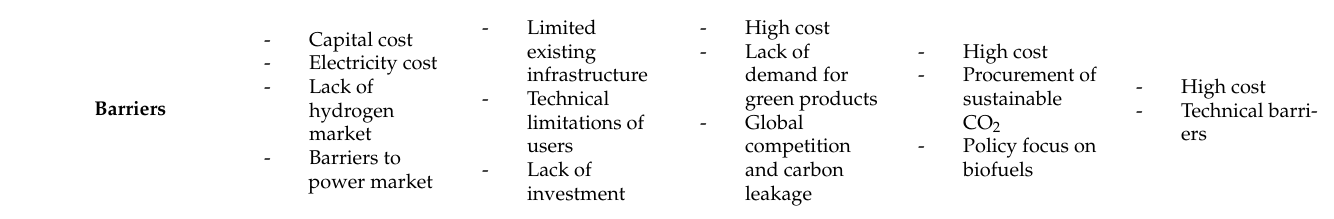
Table 1. Barriers and policies for hydrogen value chain